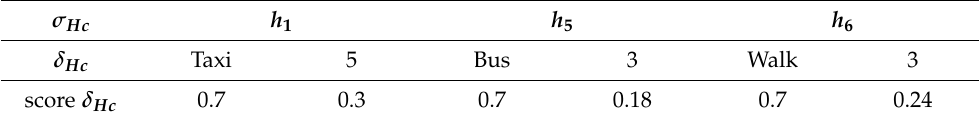
Table 12. Scores for the sub-sequence σ Hc